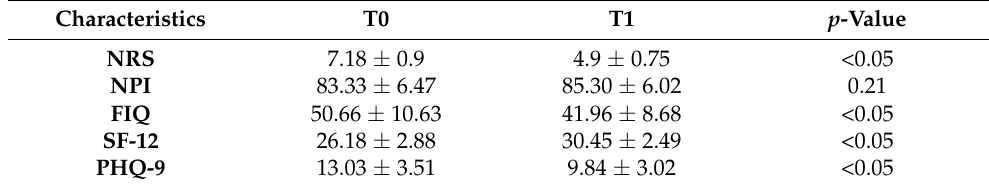
Table 2. Effects of combining functional rehabilitation with ALC supplementation in treatment group at T1.